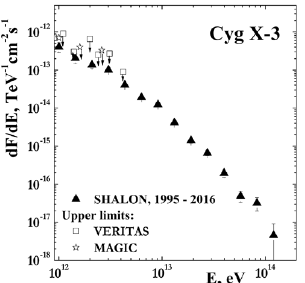
Figure 1. Di ff erential spectrum of Cyg X-3 from the SHALON data compared with the VERITAS [8] and MAGIC [9]